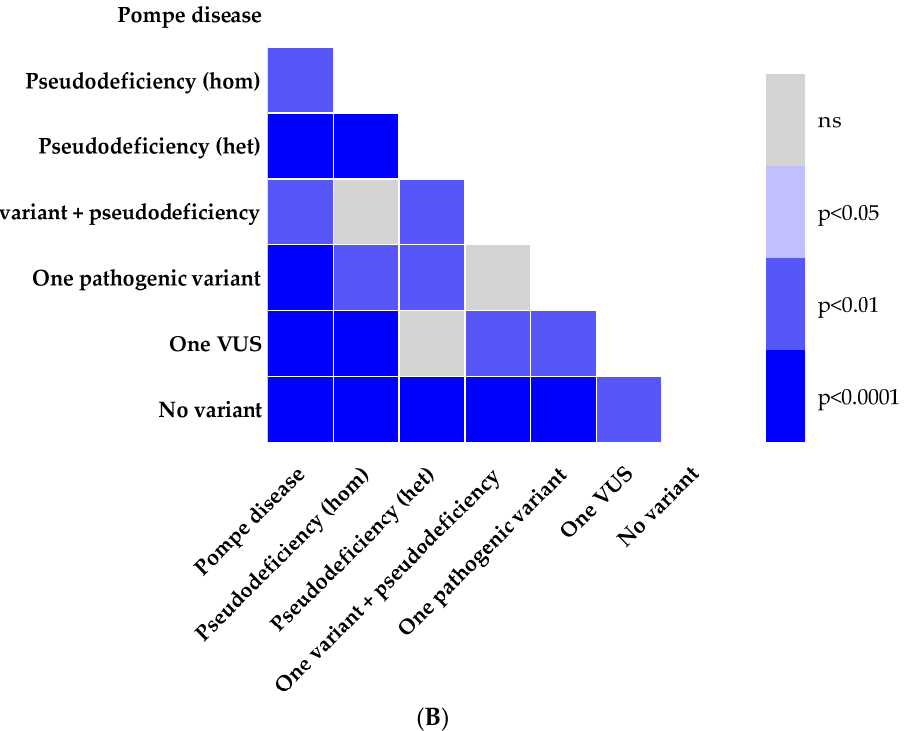
Figure 2. Acid alpha-glucosidase activity and genotypes of our cohort ( n = 1430). Since enzymatic activity was assayed in two different centres, activity is reported normalized to the lower limit of the normal reference range according to the corresponding laboratory. ( A ) Black: normal enzymatic activity (>1.00); grey: borderline enzymatic activity (0.65–1.00); red: decreased enzymatic activity corresponding to the levels observed in Pompe disease (<0.65). The median value of each subgroup is reported in blue. ( B ) p values calculated using Mann–Whitney test. ns = not significant.